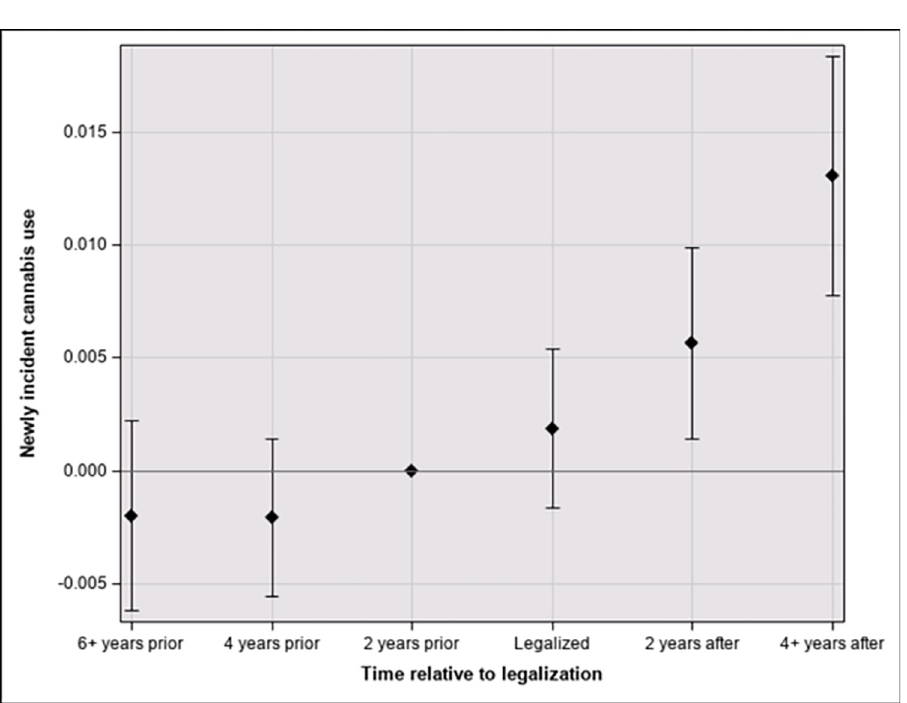
Fig 1. Effect of time since cannabis legalization on cannabis incidence in the 21 and older age group with 95% confidence intervals.